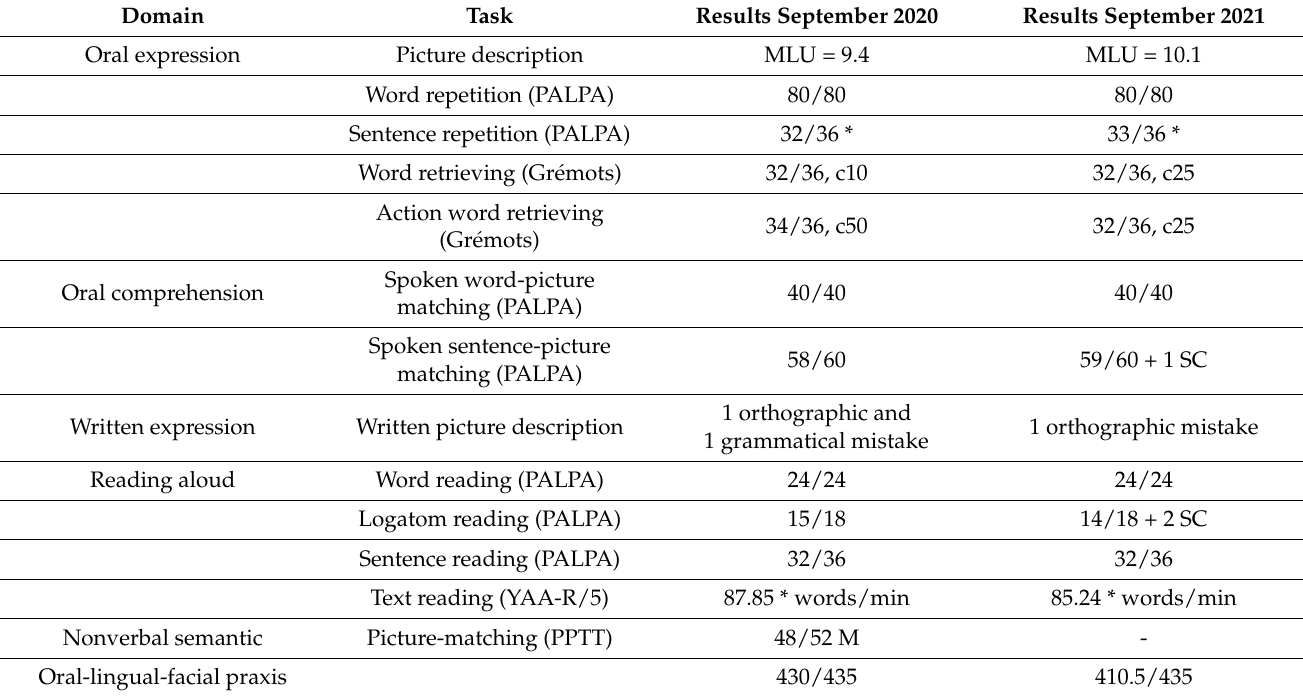
Table 2. Table resuming language performances before and at the end of the tDCS intervention program. Domain